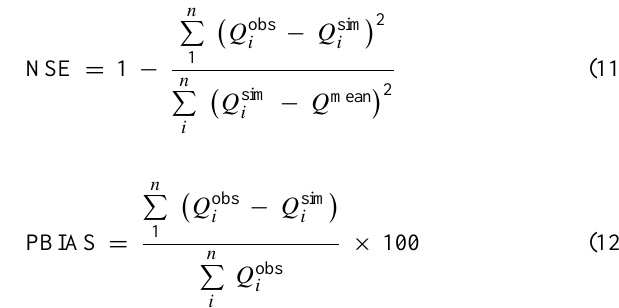
from 1961 to 1999) 4